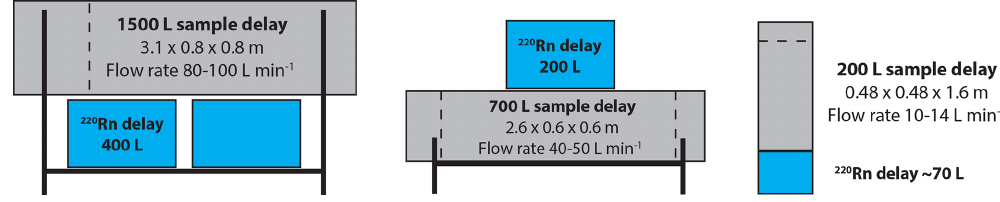
Figure 2. Size comparison (to scale), of three models of ANSTO two-filter dual flow-loop atmospheric 222 Rn